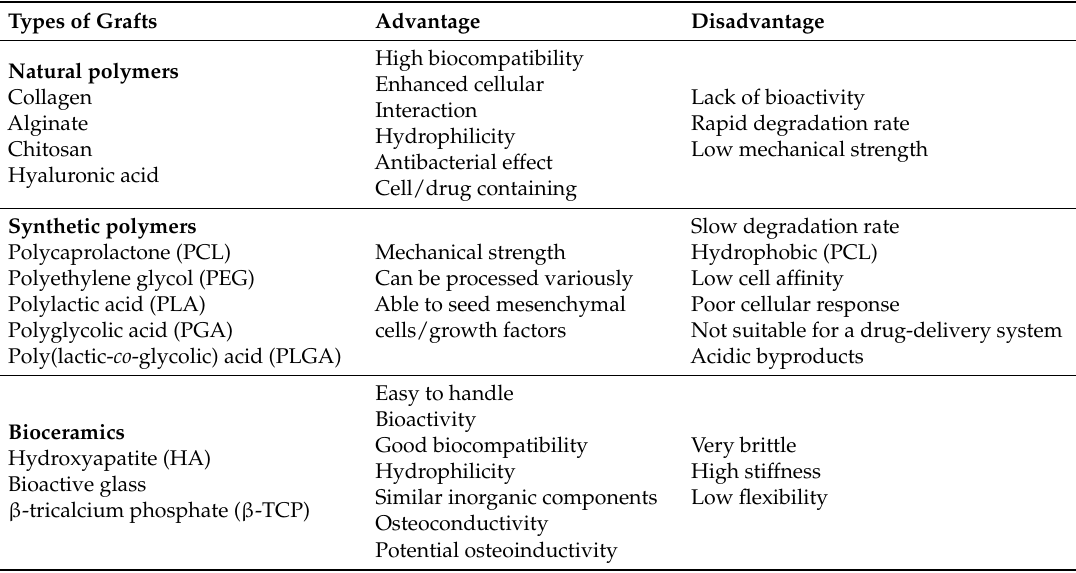
Table 2. Advantages and disadvantages according to biomaterials for the